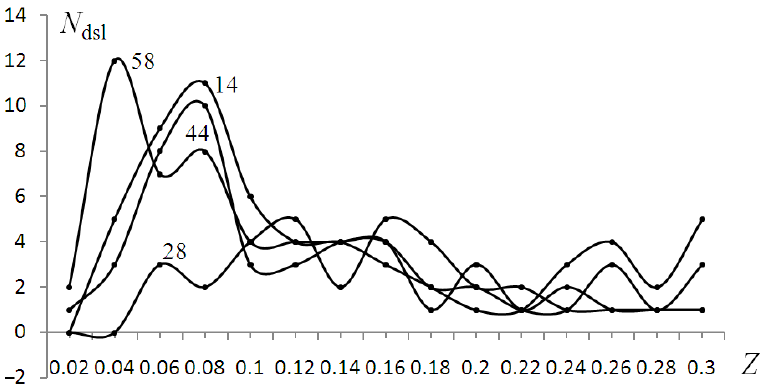
Figure 11. Dependence of dislocation number on distance Z passed by the beam. Calculation was performed for a beam with phase specified by two comas (polynomial numbers and number of curves are 7 and 8) and by trefoils (polynomials and curves are 6 and 9). The radius of registration region is 1.4 of the initial radius of the beam.